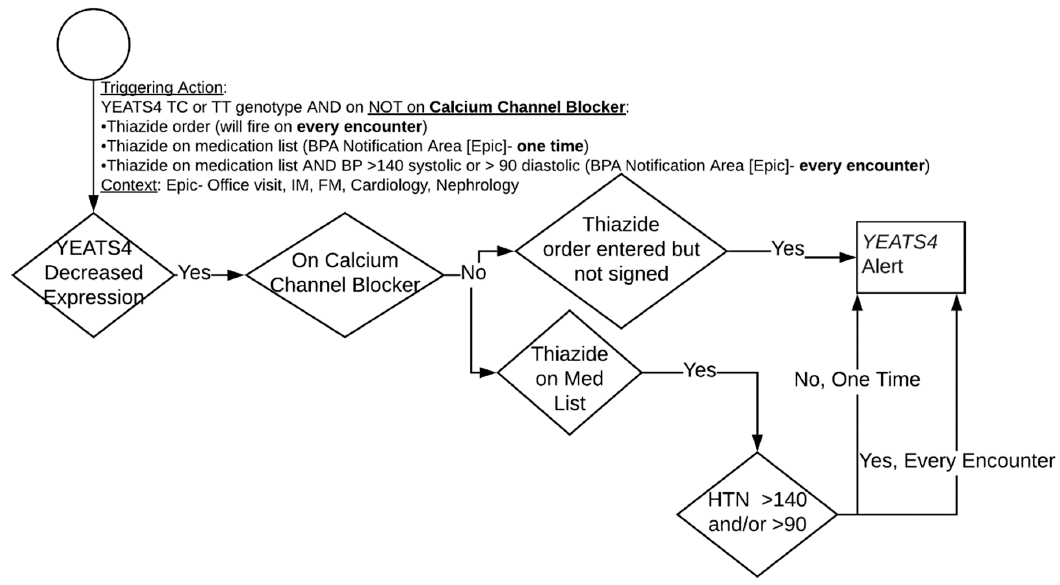
Figure 3. YEATS4 genotype guided therapeutic algorithm.